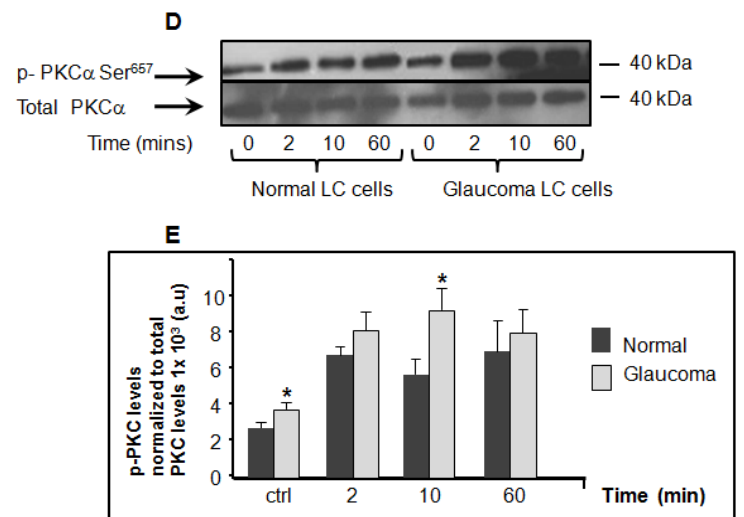
Figure 2. Western blot analysis of total and phospho-specific PKC α in normal and glaucoma LC cells. ( A , B ): typical Western immune-blotting analysis of PKC α in LC cell lysates in normal and glaucoma LC cells. Proteins (20 µg/lane) were separated on 10% electrophoresis gels, transferred to nitrocellulose membranes, and immunoblotted with phosphor-and total antibodies specific to PKC α (a 1:1000 dilution), respectively. Time-dependent expression of PKC α in LC cells exposed to isosmotic solution (resting conditions) and activity (phosphorylation) in response to hyposmotic-induced cell swelling. ( C ) Results are averages ± SE of at least 3 biological replicates obtained from three normal and three glaucoma LC cell patients. * p < 0.05 compared with time-matched controls (100%). The left panel represents the average data of PKC α expression under basal conditions (Ctrl) and at time-points of 1, 2, and 5 min of LC cells’ exposure to hyposmotic solution. The right panel shows the average data of PKC α expression/activity, under basal (Ctrl) and at time-points of 10, 20, and 30 min of LC cells’ treatment with hypotonic solution. The quantified data are presented in two separate bar graphs, to enhance the difference in PKC α expression/activity between normal and glaucoma LC cells. Note that the scale bar in the left panel (first 5 min) is twice that in the right panel (from 10 to 30 min). ( D ) Representative Western blot analysis of PKC α expression/activity in normal and glaucoma LC cells, illustrating a time-course experiment under isotonic (Ctrl) conditions and after 2, 10, and 60 min of exposure to hyposmotic solution. The time-points chosen here are the time- points where PKC α reached the two transient maximum peaks (2 min and 10 min), and the exposure to hypotonic cell stretch was extended to 60 min. ( E ) Average data ± SE of biological replicates. * p < 0.05 compared with time-matched controls (100%). To confirm equal amounts of protein loading, membranes were washed and reblotted with beta-actin antibody (Figure 2A,B).